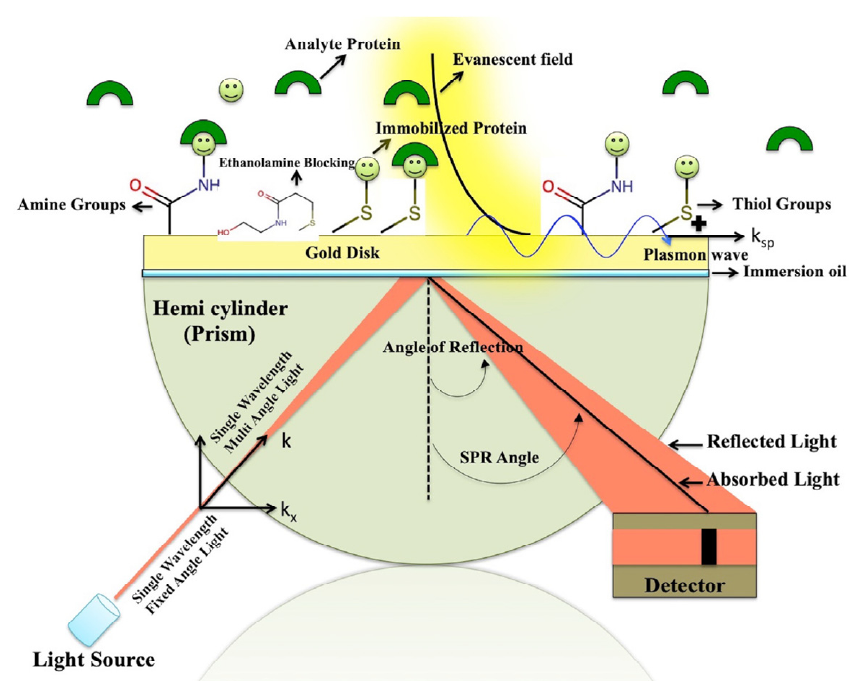
Figure 2. The functionality of SPR biosensors. When the analytes interact with the ligands fixed on the ‘surface’, the dielectric index on the gold ‘surface’ changes, and the reflection maximum is seen at a different angle. This angular shift is the result of the interactions between the analyte and the ligand. (Reprinted with permission [69]. Copyright © 2020, Authors. Exclusive licensee: Bio-pro- toco1 LLC.) Table 1. Applying surface plasmon resonance biosensors in medical diagnosis.